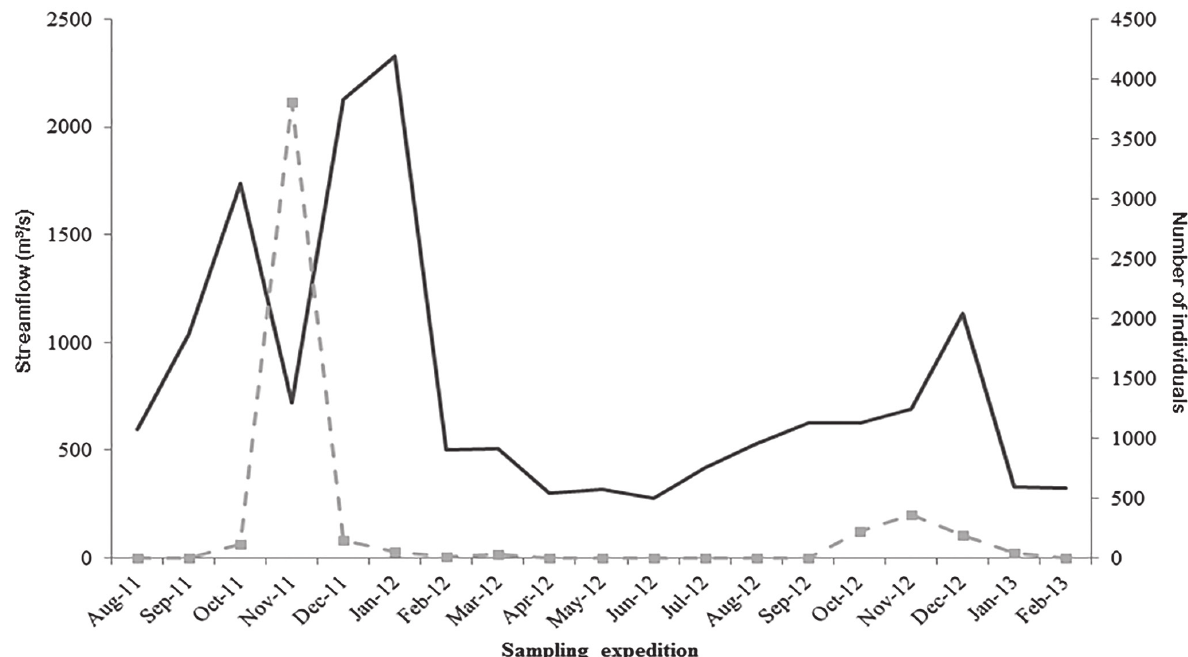
Fig. 3. Variation in the mean monthly river flow (solid line) and number of larvae (dashed line) of the Paraíba do Sul River near Campos dos Goytacazes municipality (RJ) during two rainy seasons (October to March), with same effort. During the dry season (April to September), the effort was